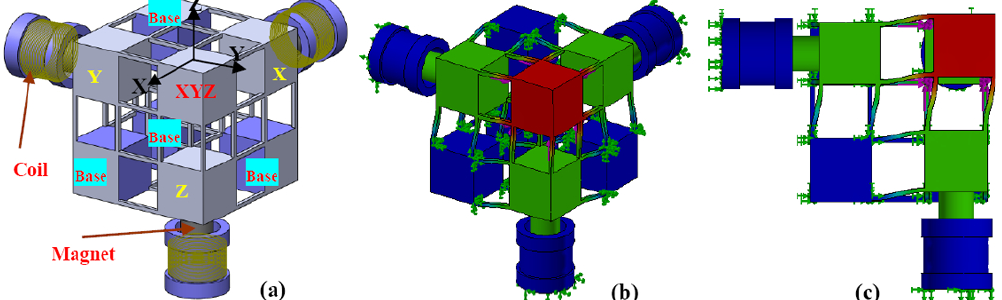
Figure 3. Energy harvesting devices: (a) Energy harvesting device based on a monolithic decoupled XYZ CPM; (b) Perspective view of FEA resutls in deformation; (c) Top view of FEA results in